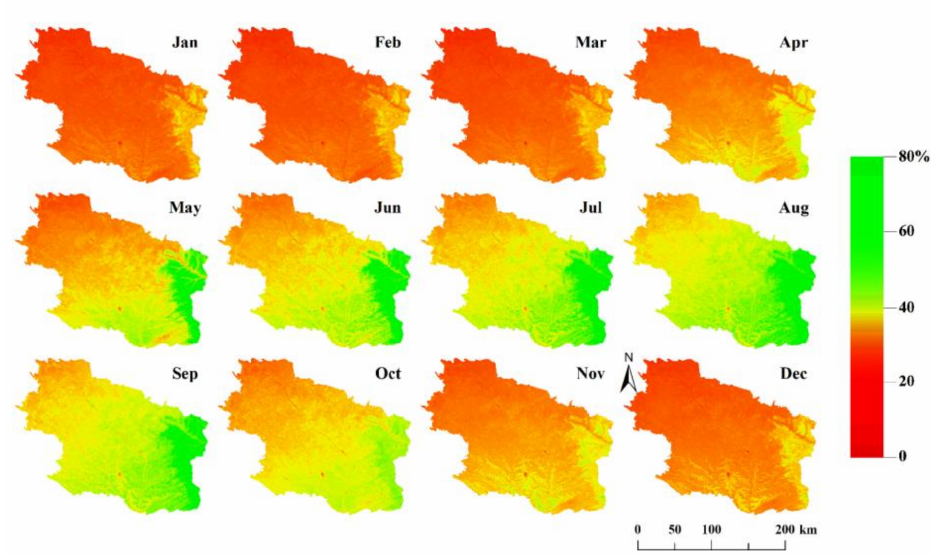
Figure 2. Spatial distribution of FVC monthly variation in Qingyang.